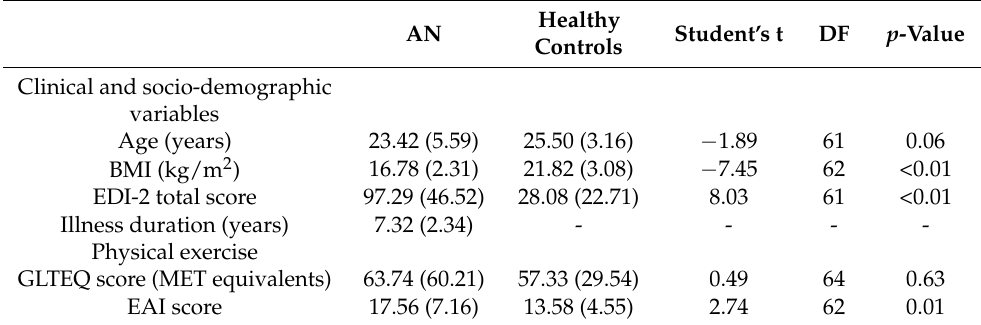
Table 1. Characteristics of the population of patients with anorexia nervosa and healthy controls. Standard deviations are reported in brackets.